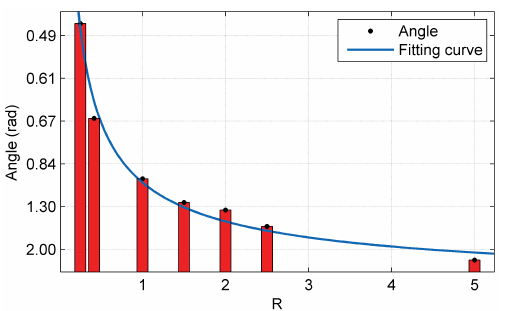
Figure 13. Distribution of relative angle (rad) with island size ( R ). The blue line is the fitting